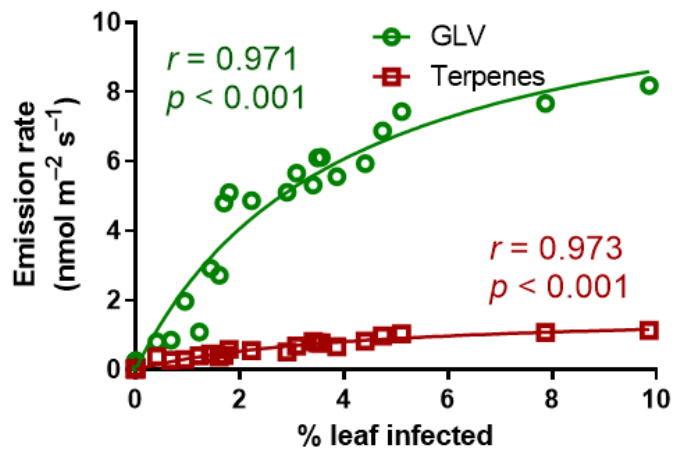
Figure 5. Correlations of monoterpene and green leaves volatiles emission rates with the percentage of A. erinea infection in J. regia leaves ( n = 25). Measurement conditions as in Figure 2. The data have been fitted using non-linear regression y = a · x/(b + x).